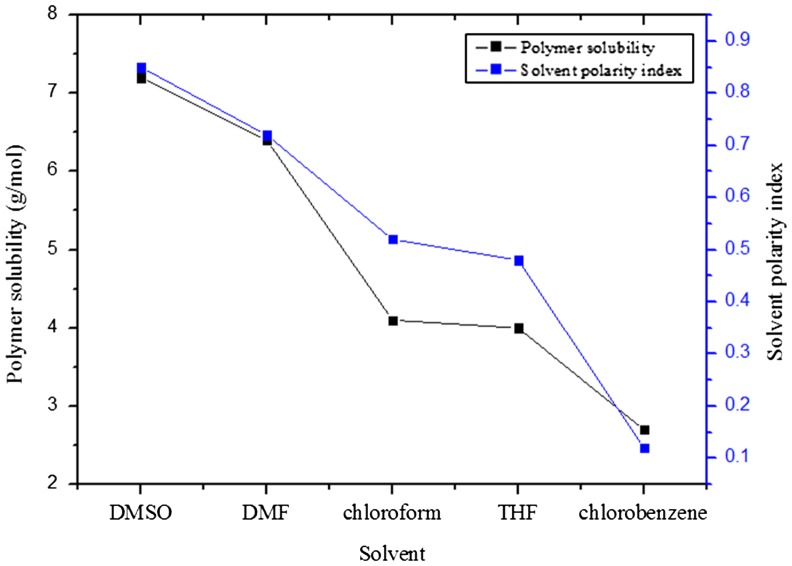
Solubility of DBSA-doped PNVC–Ppy vs. polarity indices of the solvents.